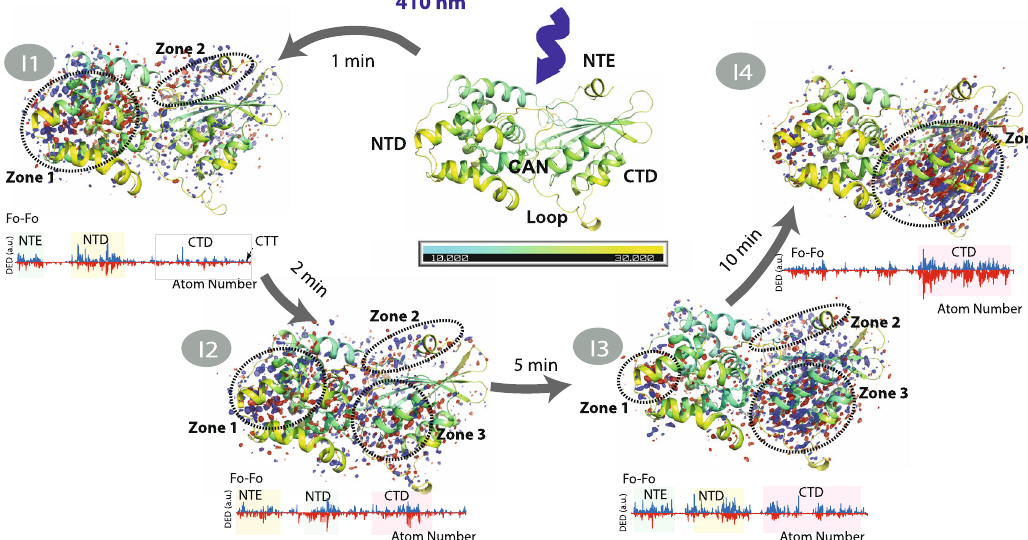
Fig.5|OverallstructuraleffectofilluminationonOCPstructure. Datasetsfrom which all images are derived (Dark, I1 – I4) have a resolution of 1.3 – 1.4Å (Sup- plementary Table 1) and time points at which crystals were cryo-trapped are indicated for I1 – I4. Each structure is coloured in cyan-yellow gradient based on B-factor (10.0 (cyan)-30.0 (yellow)). (I1- I4, upper panel) F 0 – F 0 Difference electron density (DED) maps (blue/red at ±3.5 σ ) for the four states are shown beloweachcorresponding structure:(I1)1min(F I1 – F Dark ),(I2)2min(F I2 – F Dark ), (I3)5min(F I3 – F Dark )and(I4)10min(F I4 – F Dark ).TheDEDsignalsarelocalizedin